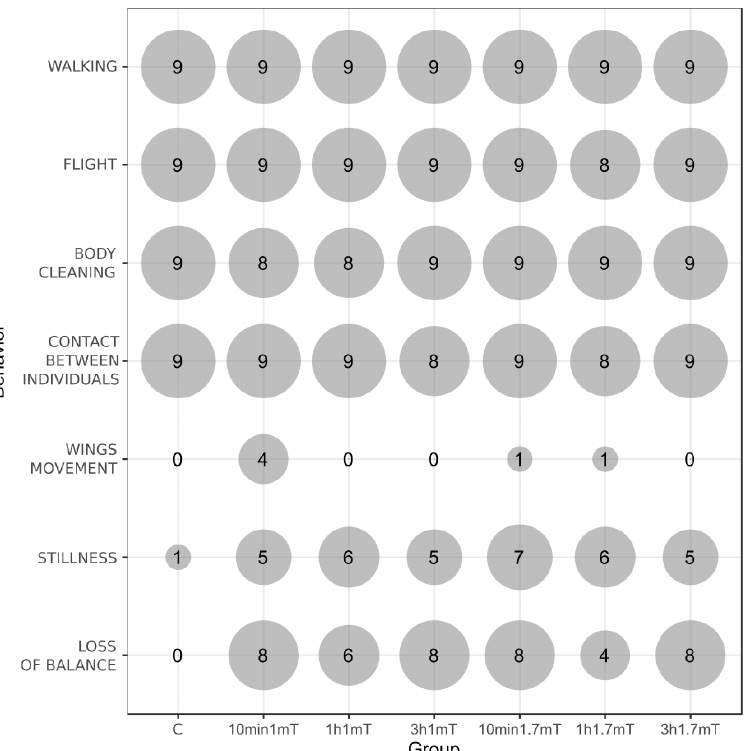
Figure 3. Number of bees per group that presented particular behaviors (areas of circles correspond to values). Total number of observed individuals were 9 in each group. Details under Figure 1.